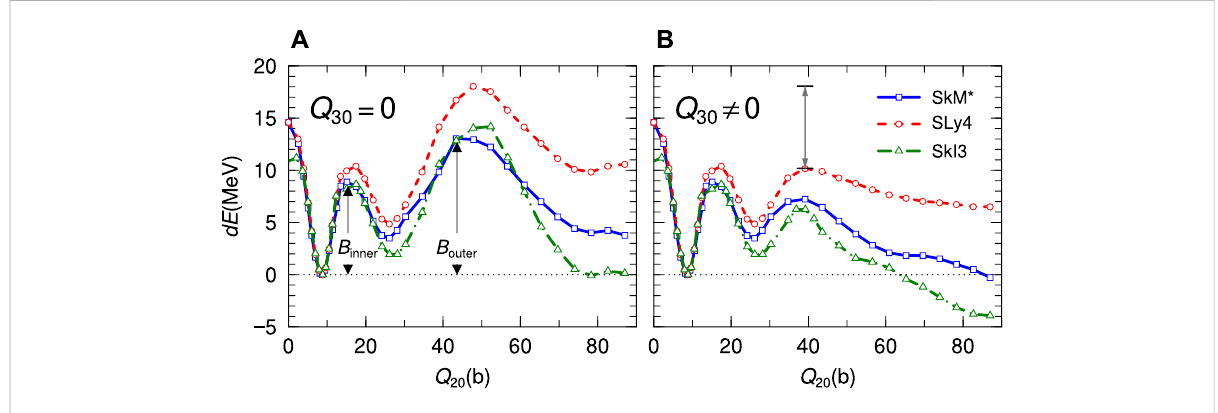
FIGURE 2 Energies of the symmetric path (A) and fi ssion path (B) of 236 U as functions of Q 20 for the three EDFs (SkM*, SLy4, and SkI3). The effect of mass asymmetry for SLy4 is indicated by the arrow in right panel.